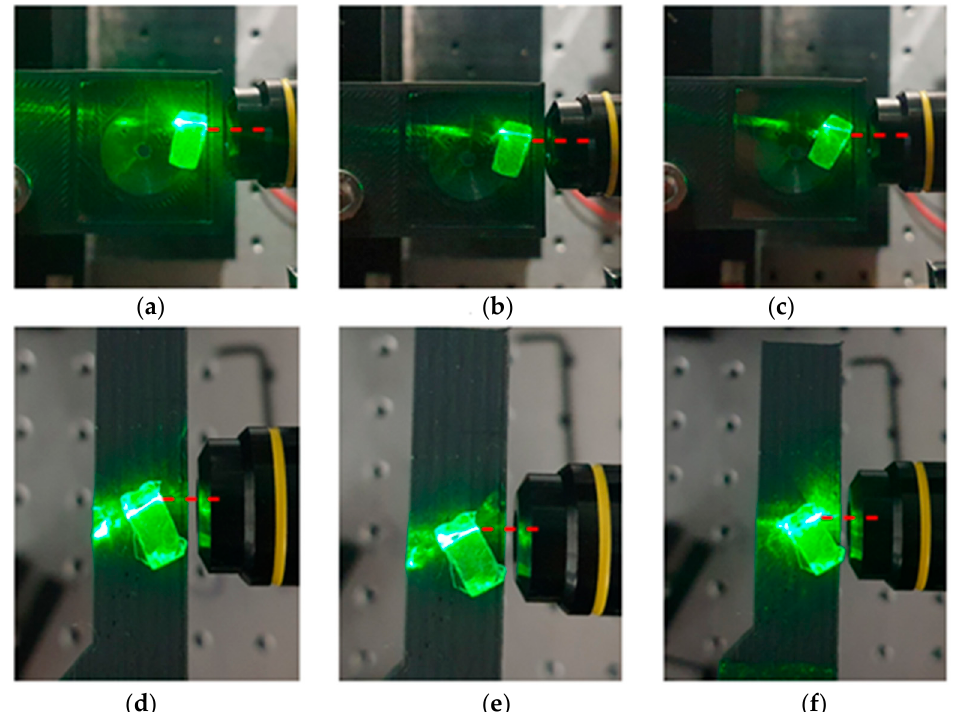
Figure 2. Phosphate glass waveguide (W-Lens) with plano-convex lens ( a – c ) positioned at ( a ) 15°, ( b ) 20° and ( c ) 25° of the incident visible light, and (W-Obj) with objective lens ( d – f ) at ( d ) 30°, ( e ) 35° and ( f ) 40°, showing the threshold of the acceptance angle. Red dashed lines indicate the zero-degree incident probe light. Writing irradiance for both W-Lens and W-Obj glasses was set to 200 kHz repetition rate, 3 μ J pulse energy and 5 mm s − 1 scanning speed.